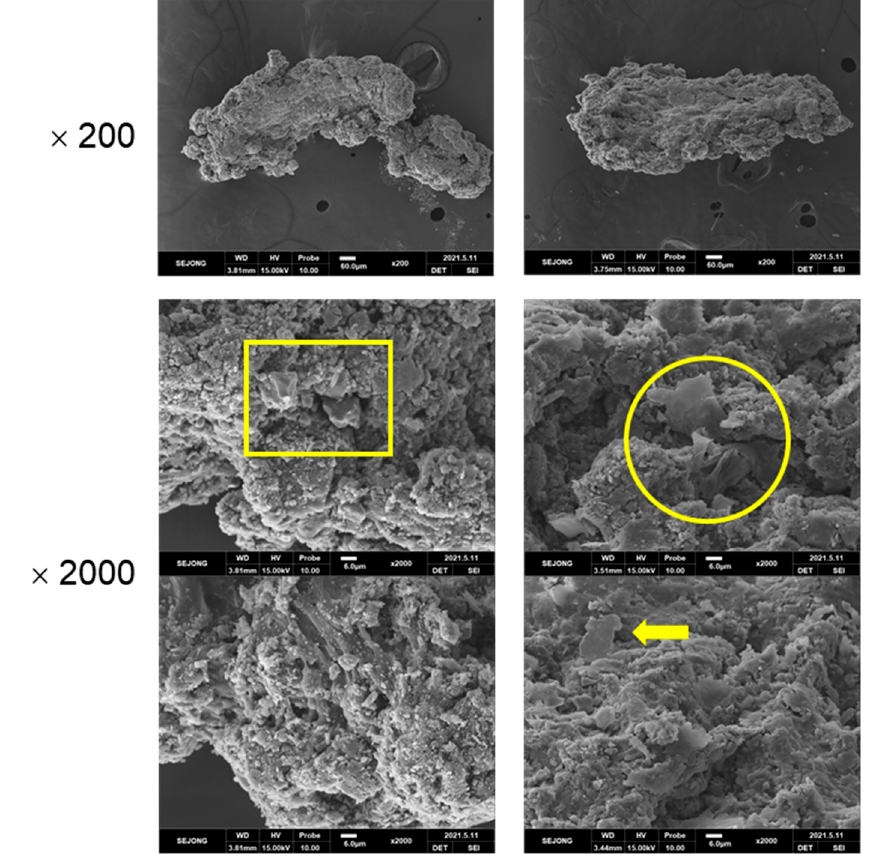
Figure 5. SEM images of the model TRWPs made of the chloroform-treated TWPs (212–500 μ m) and asphalt pavement wear particles (20–38 μ m). The scale bars are 60 and 6 μ m for the magnifications of 200 and 2000, respectively.